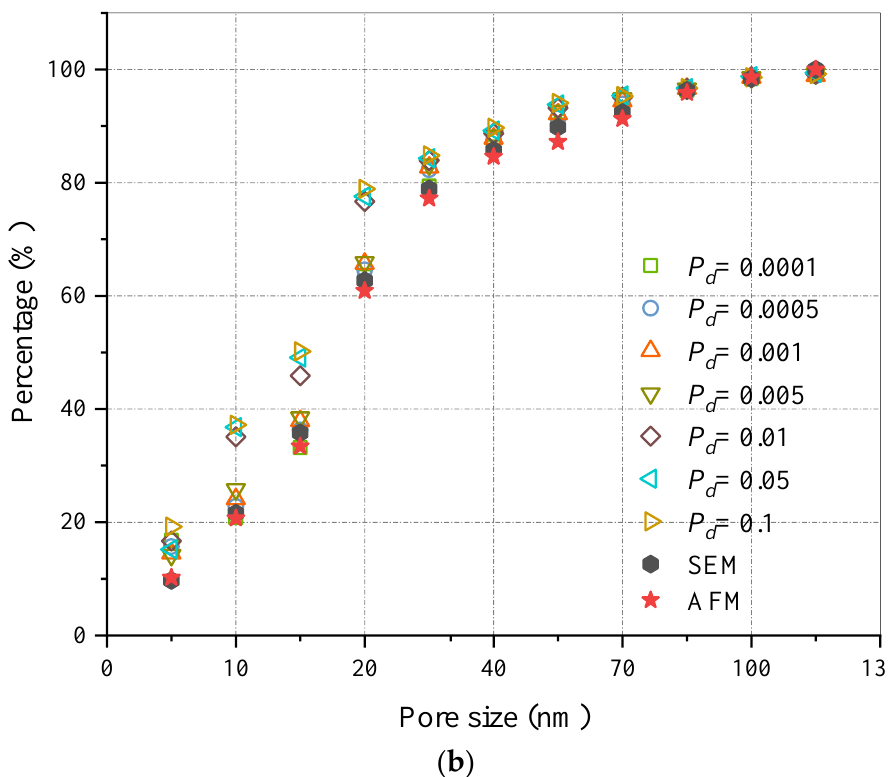
Figure 5. ( a ) Pore distribution statistics ( p d = 0.001). ( b ) Pore distribution statistics ( p m = 0.001).